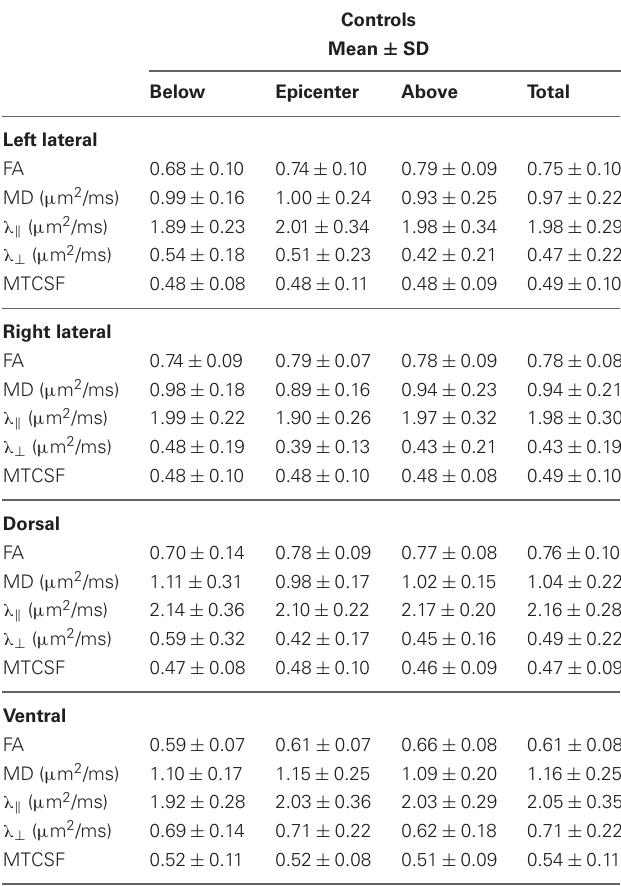
Table 3 | Injury region specific data comparison of